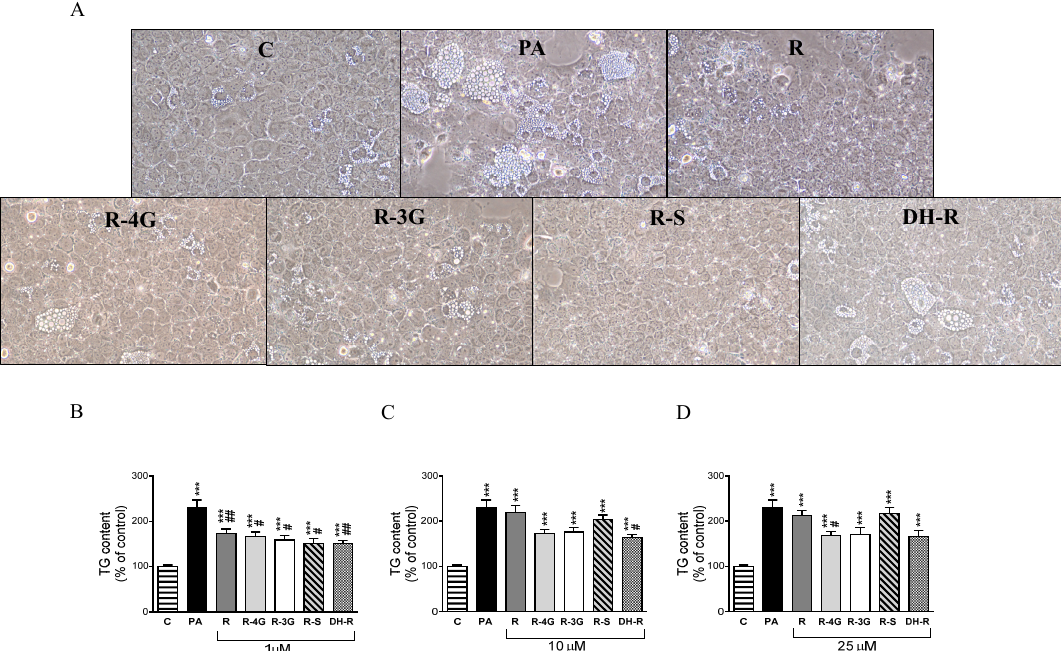
Figure 1. Optical microscopy images showing structural features at 1 µM ( A ) and triglyceride content in AML12 hepatocytes exposed to 0.3 M palmitic acid (PA) with or without resveratrol (R) or its metabolites (R-4G, R-3G, R-S and DH-R) at 1 µM ( B ), 10 µM ( C ) or 25 µM ( D ) for 18 h. Data are means ± SEM. *** p < 0.001 vs. control group. # p < 0.05 and ## p < 0.01 vs. PA group.